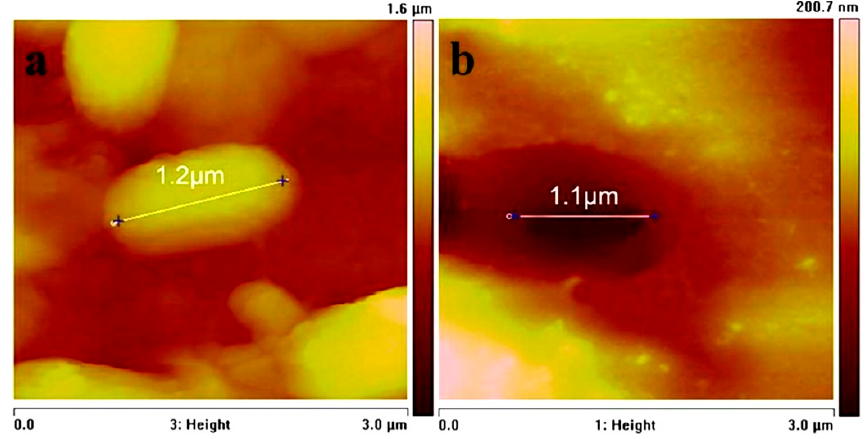
Figure 7. AFM topographical images of the steel plates after incubation for 90 days in the ASW ( a ) before and ( b ) after the removal of the biofilm that demonstrates the obvious pitting of the steel samples after the removal of the bacterial biofilm.